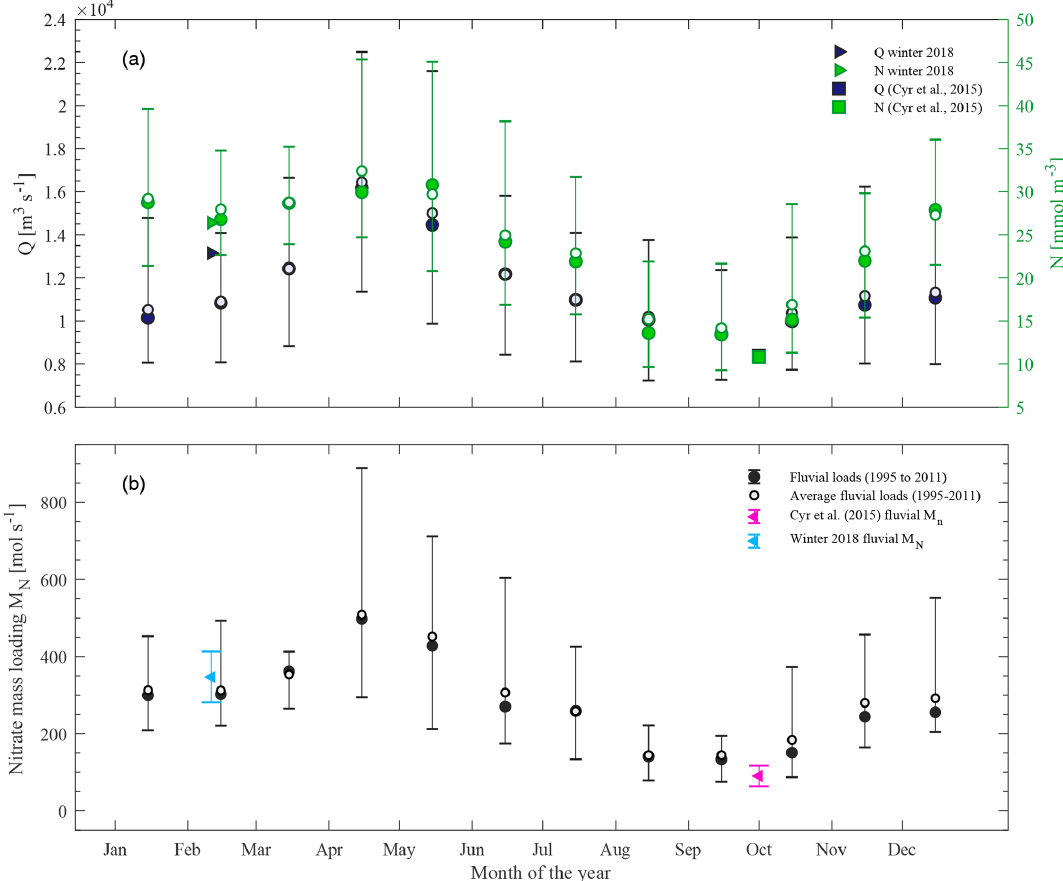
Figure 6. (a) Monthly statistics of the freshwater flow rates at Quebec City from 1995 to 2011 using the inverse modeling techniques described by Bourgault and Matte (2020a). The secondary green axis represents the monthly statistics of nitrate concentrations measured at Quebec City during this same period (Hudon et al., 2017). (b) Monthly statistics of the mass nitrate fluvial loads estimated from Eq. (1). The bars in both panels extend from the 5th and 95th percentile for each month’s data and are centered around the median (dark circles). The open circles denote the monthly averages. The error bars on the instantaneous nitrate loads for our winter 2018 campaign and Cyr et al. (2015) late summer observations are the errors propagated from the flow estimates. The nitrate concentrations for Cyr et al. (2015) were interpolated from the temporal time series of Hudon et al. (2017) at Quebec